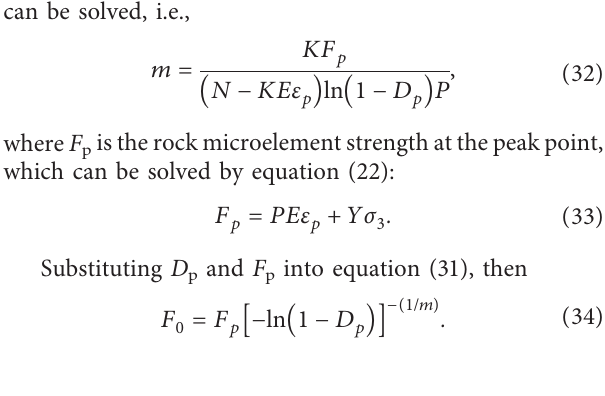
Figure 1: Stress threshold and stress stage